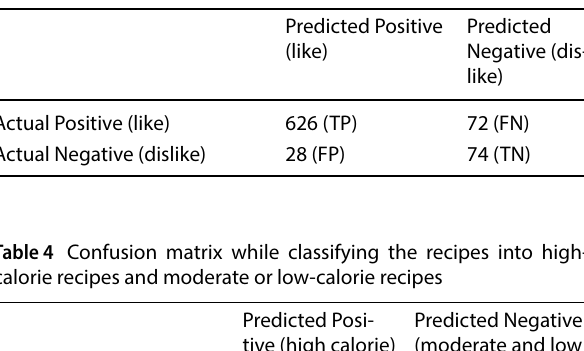
Table 3 Confusion matrix while classifying the recipes into acidic and non-acidic(basic)